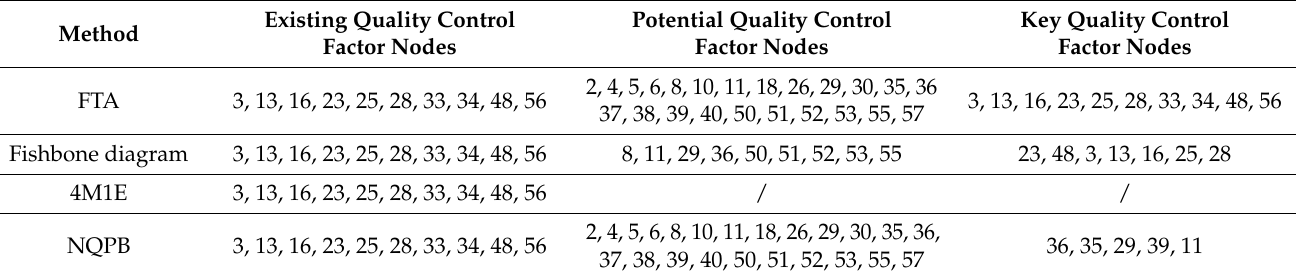
Table 5. Quality control factors of Project A identified by the four